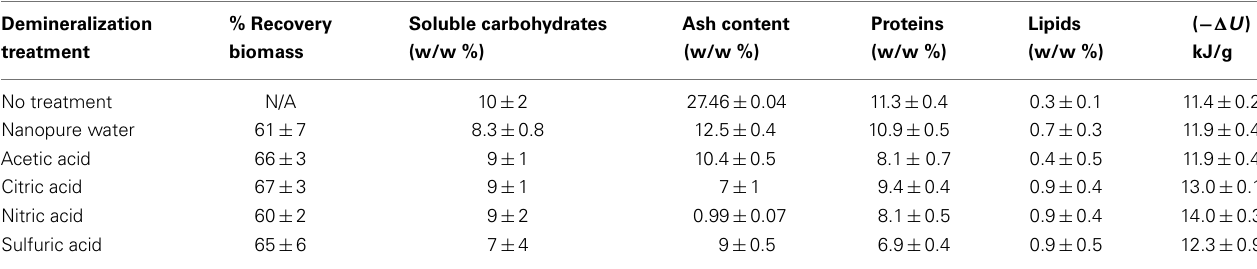
Table 1 | Recovery percentage, chemical content and changing in internal energy of algae biomass after the demineralization treatment (all values are reported on dry biomass basis) .